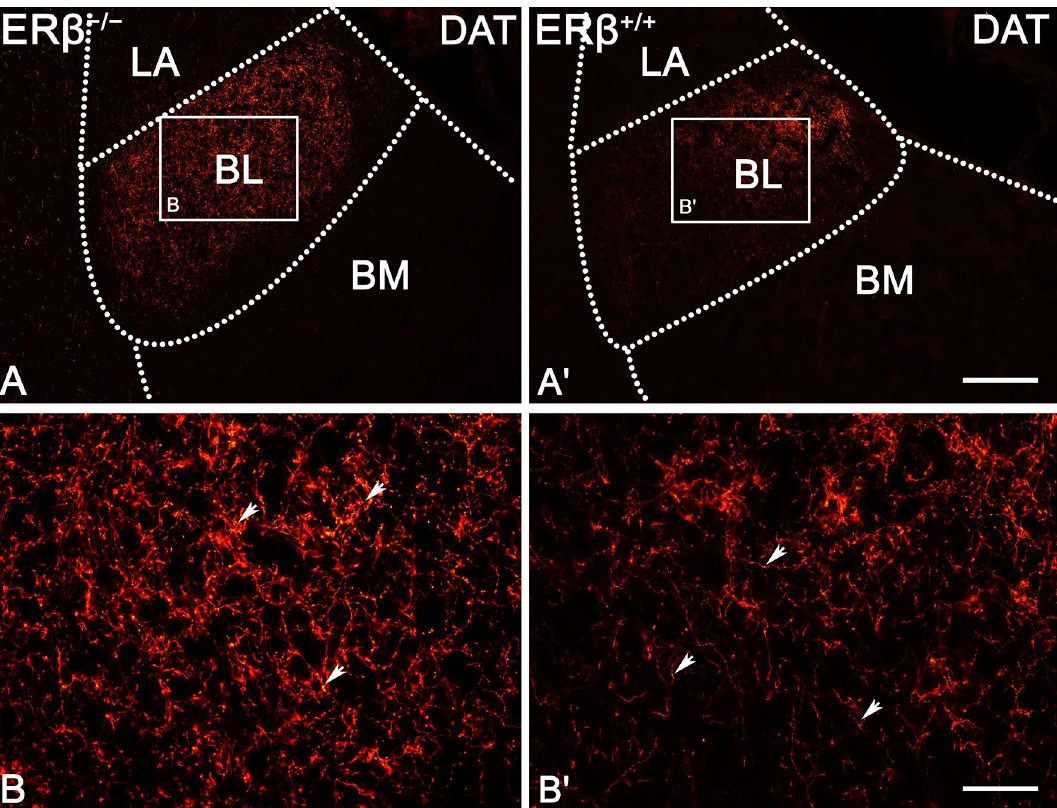
Figure 3. Representative colour photomicrographs illustrating the staining pattern of dopamine transporter (DAT) in the amygdala of ERβ knock-out (ERβ −/− ) and wild-type (ERβ +/+ ) mice, n = 6 per group. ( A , B ) ERβ −/− mice. ( A ′ , B ′ ) ERβ +/+ mice. Note increased density and signal intensity of DAT in ERβ −/− mice ( A , B ) when compared to ERβ +/+ littermates ( A ′ , B ′ ). The arrows indicate areas where fiber swellings are located. LA—lateral nucleus, BL—basolateral nucleus, BM—basomedial nucleus. The scale bar applies to all microphotographs, and it corresponds to the length of 200 µm in ( A , A ′ ), and 50 µm in ( B , B ′ ).